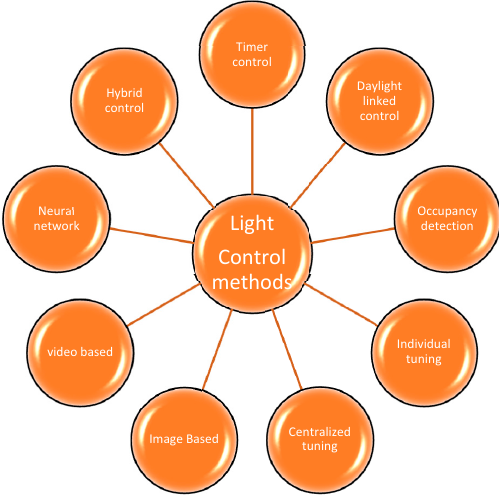
Figure 1. A survey of different light control methods.